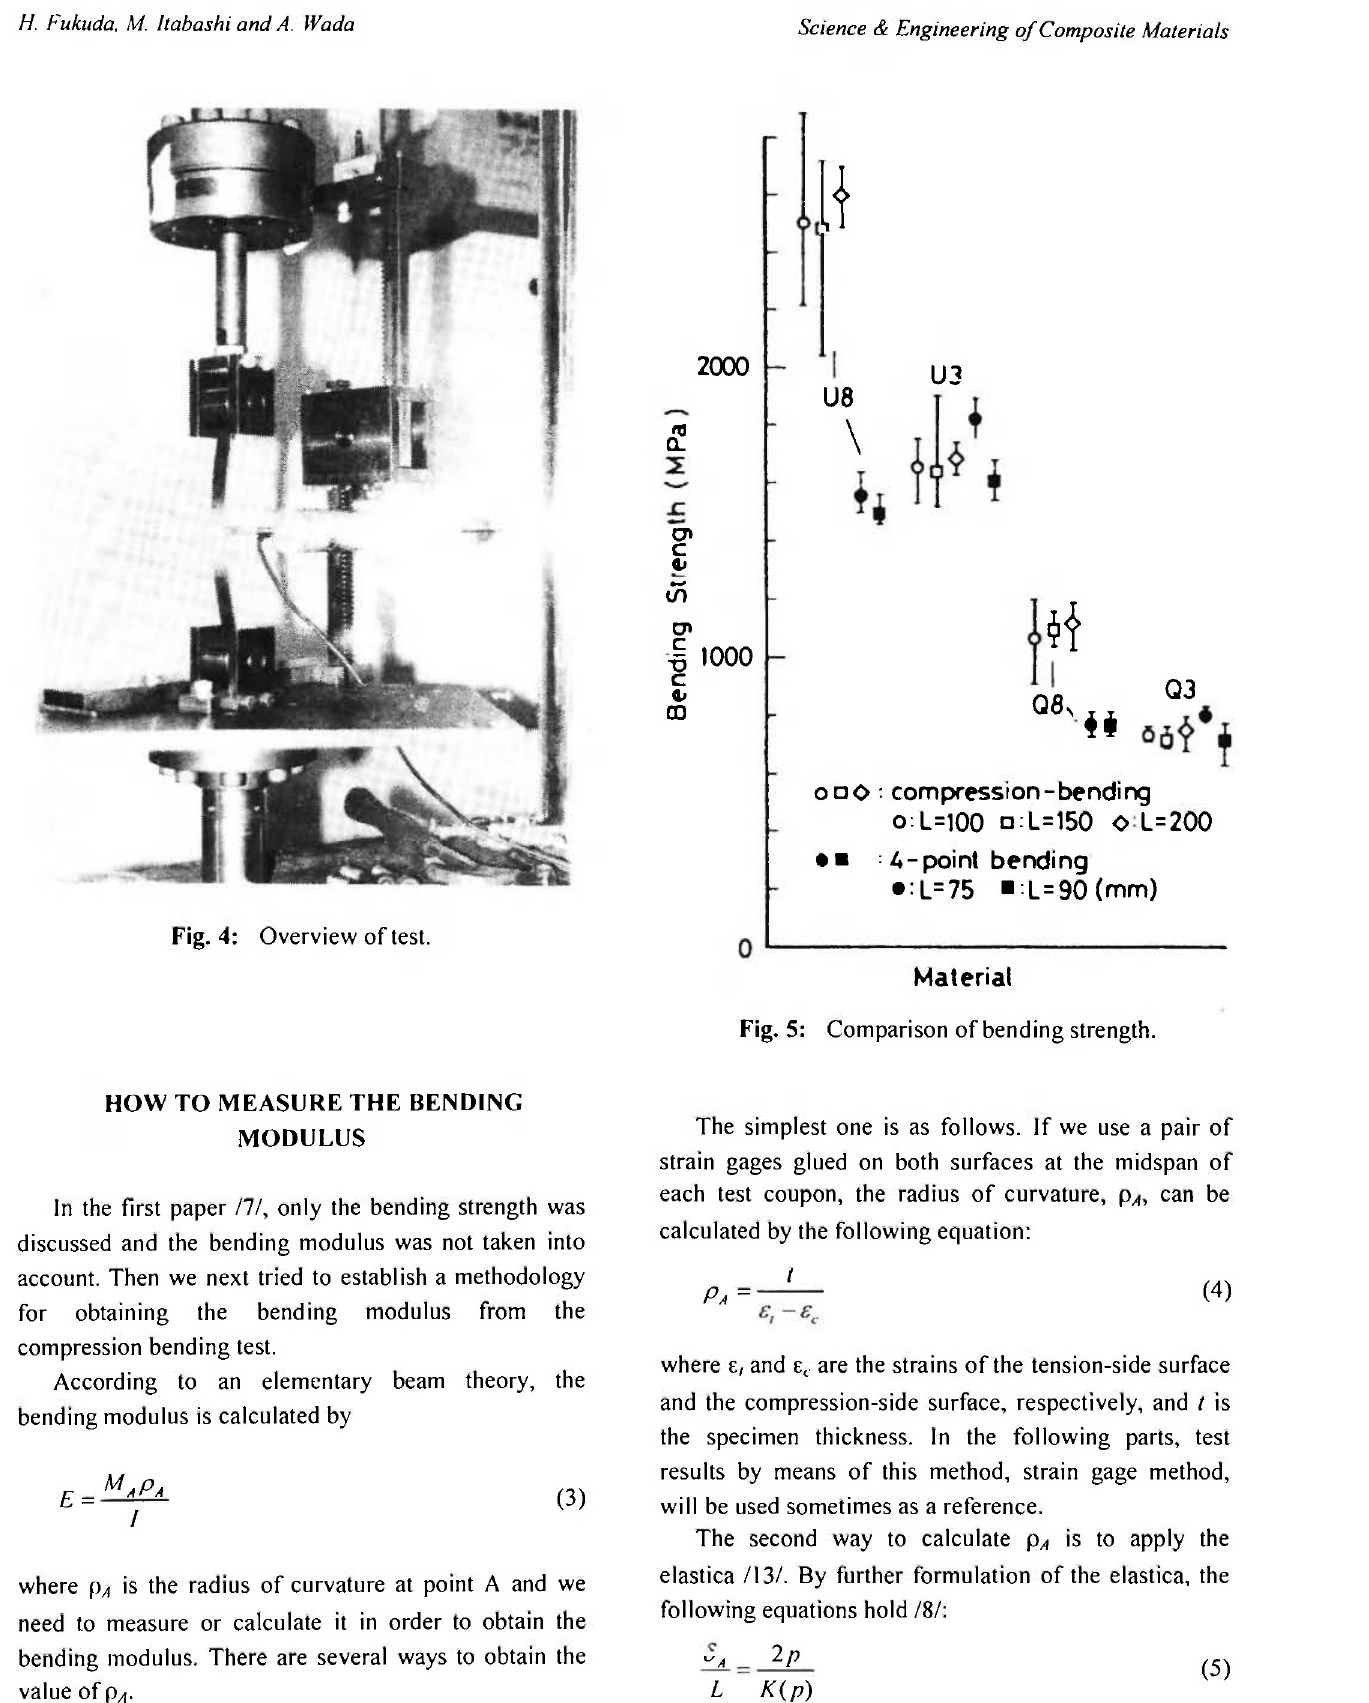
Fig. 5: Comparison of bending